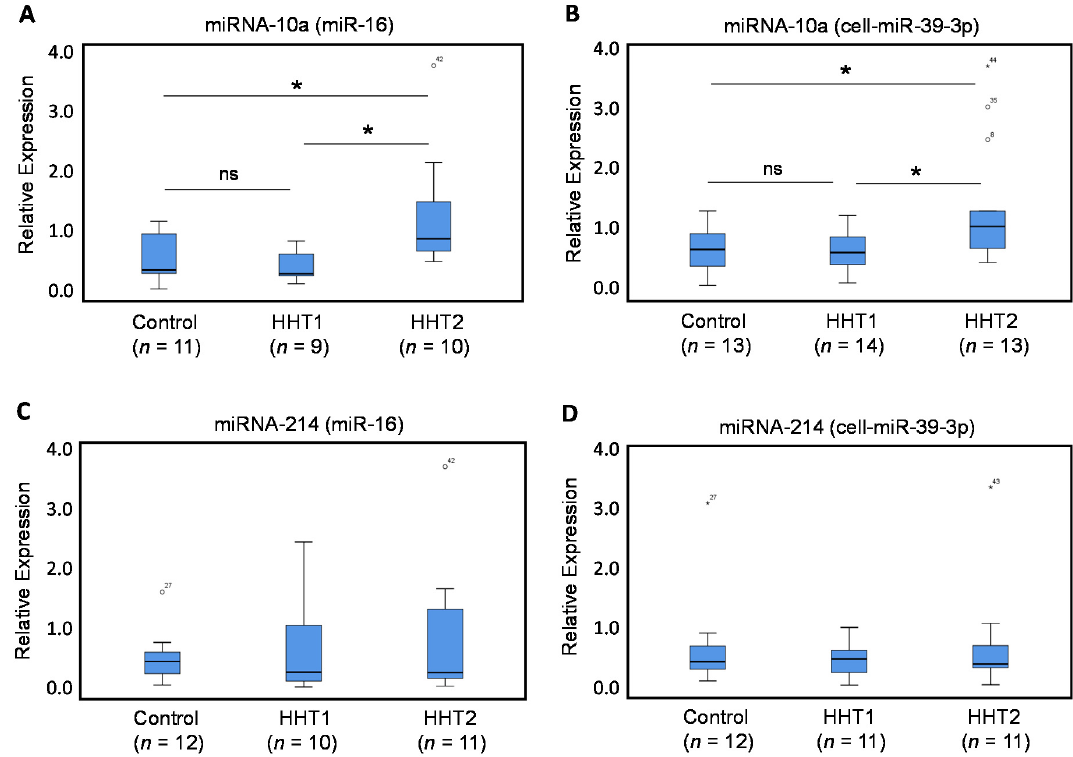
Figure 2. qRT-PCR of miRNA-10a and miRNA-214. Total plasma RNA was isolated from HHT1 and HHT2 patients and control subjects. Relative expression levels of miRNA-10a ( A , B ) and miRNA-214 ( C , D ), measured by qRT-PCR using miR-16 ( A , C ) or cel-miR-39-3p ( B , D ) as normalizers. Symbols outside the box plot represent extreme values ( ◦ ) and outliers (*) with their corresponding sample numbers. The number of samples analyzed is indicated in parentheses. Experiments were performed in triplicates. (* p < 0.05; ns, not significant).